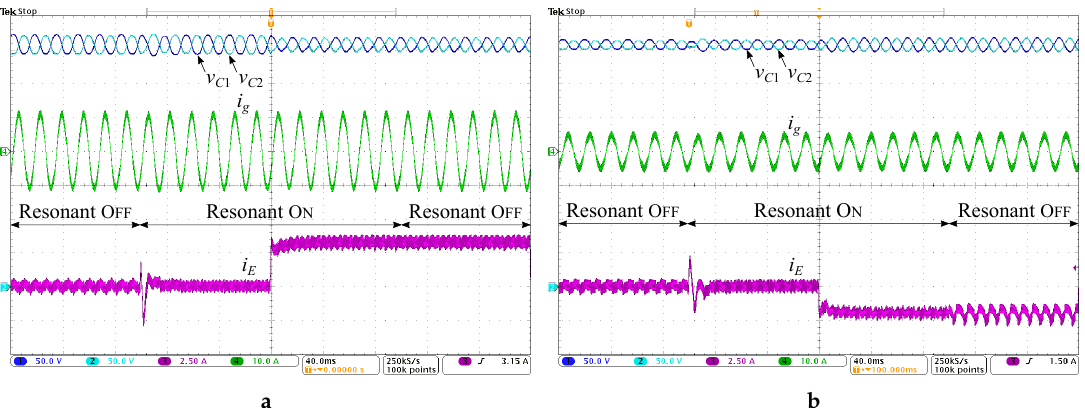
Figure 10. Experimental results showing the effect of the resonant control action and step responses of i E . ( a ) i E step response for the ESS commutation from floating to discharging mode. ( b ) i E step response for the ESS commutation from floating to charging